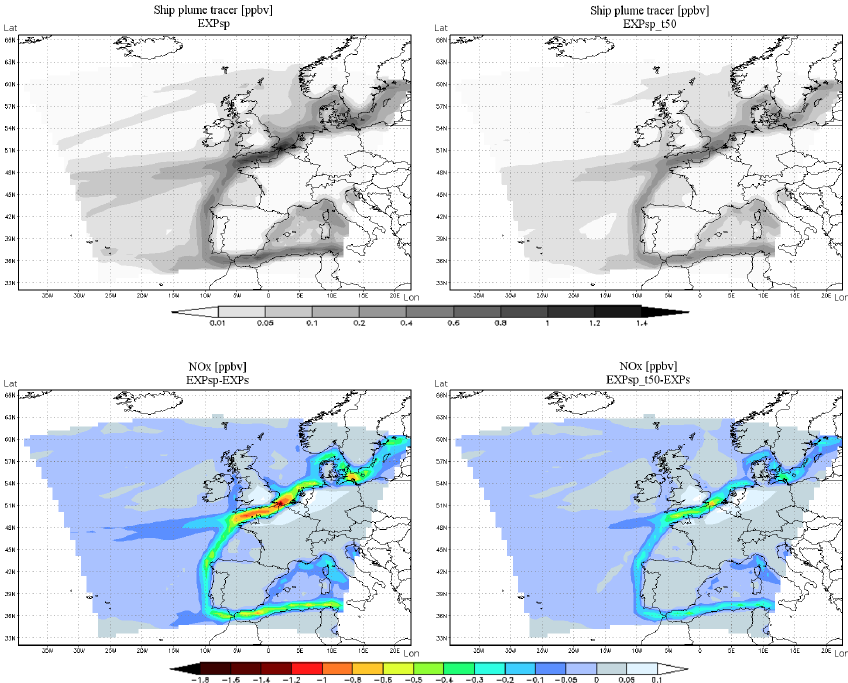
Fig. 11. Sensitivity test on the dilution time τ . Upper row shows the tracer distribution for the default experiment EXPsp (left) and experiment EXPsp t50 (right) with dilution time reduced by 50%. Lower panels show the surface NO x change when applying the ship plume parameterization for “full” (left) and reduced (right) dilution time.